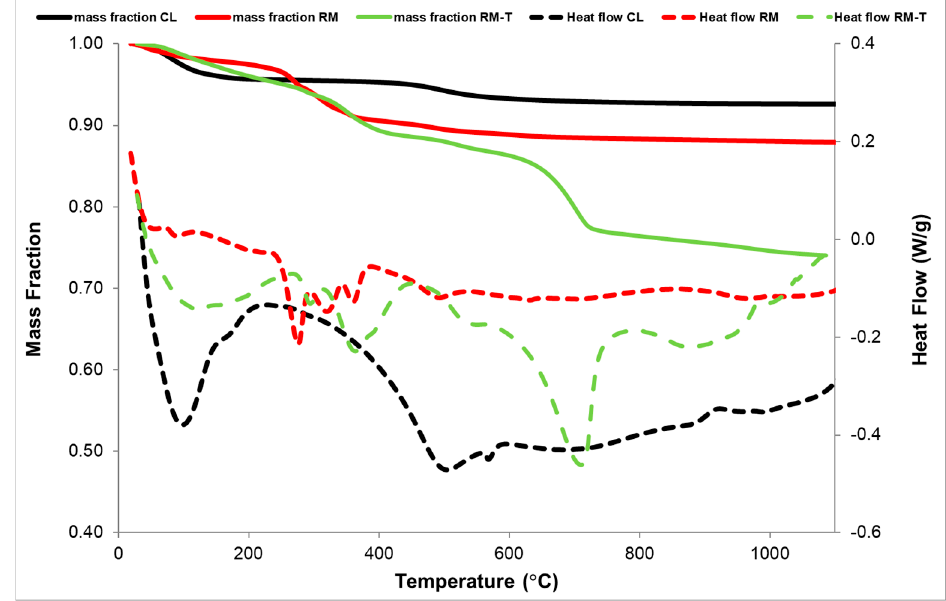
Figure 4. Thermogravimetric analysis of RM, RM-T, and CL.